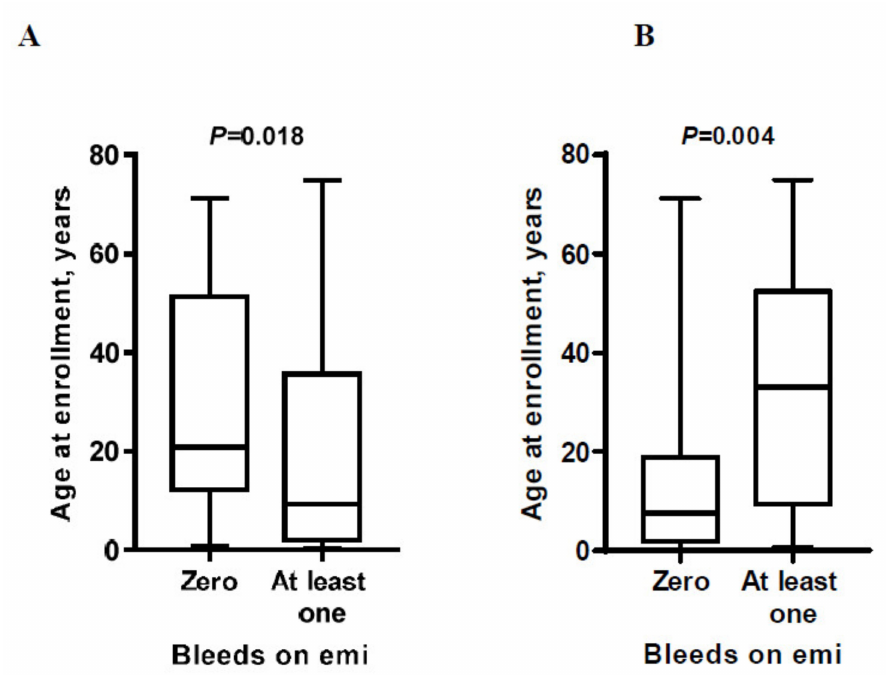
Figure 5. The association between age and the risk of traumatic ( A ) or spontaneous ( B ) bleeding episodes during 18 months of emicizumab prophylaxis. The data are presented as box-and-whisker plots. The boxes span the 25th to the 75th percentile, the line inside each box denotes the median, and the whiskers span the lowest to the highest observations. The Mann–Whitney U test was used to compare the patient subgroups. The resulting P values are shown in the graph. Patients with at least one traumatic bleed were statistically younger ( A ), whereas patients with spontaneous bleeds were statistically older ( B